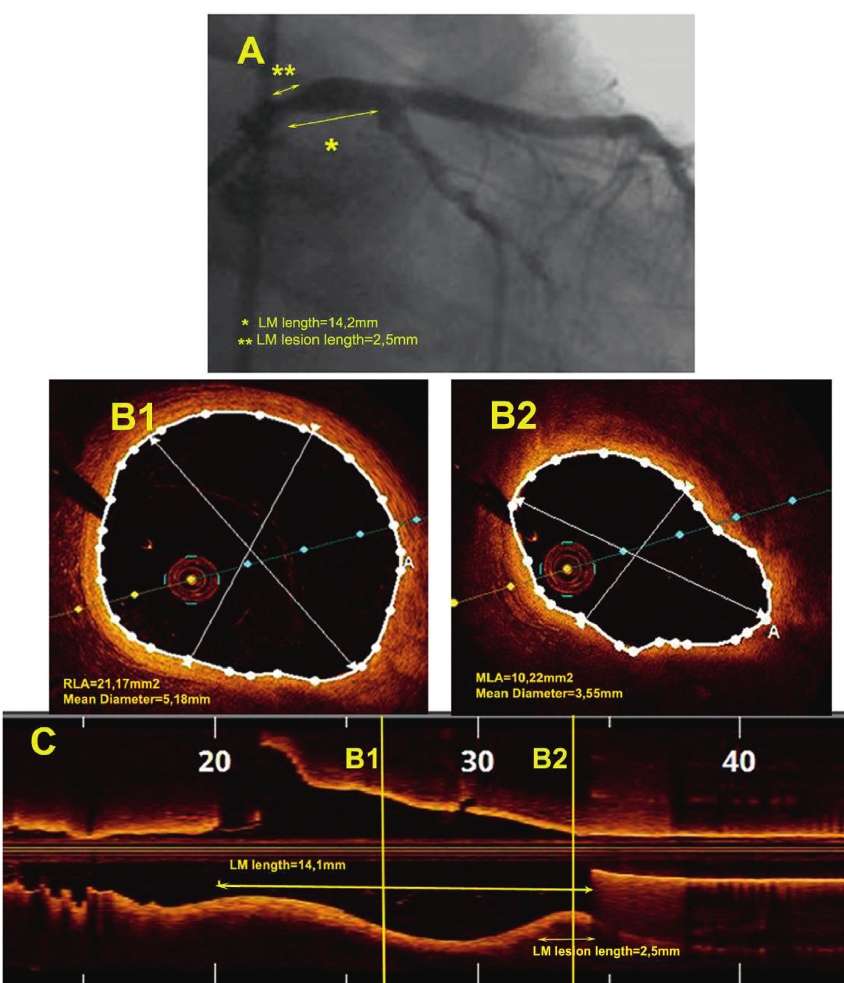
Figure 1: Example of proximal left main (LM) stenosis. (a) Angiographic view showing a proximal LM stenosis. The measurements of the LM length and the lesion length are also presented (double arrows). (b). Optical coherence tomography (FD-OCT) cross-sectional images of the LM with measured lumen dimensions. B1: reference lumen area (RLA); B2: minimum lumen area (MLA). (c) Longitudinal FD-OCT reconstruction of the LM showing the location of measurements (B1 and B2) and the measurements of the total LM length and the lesion length (double